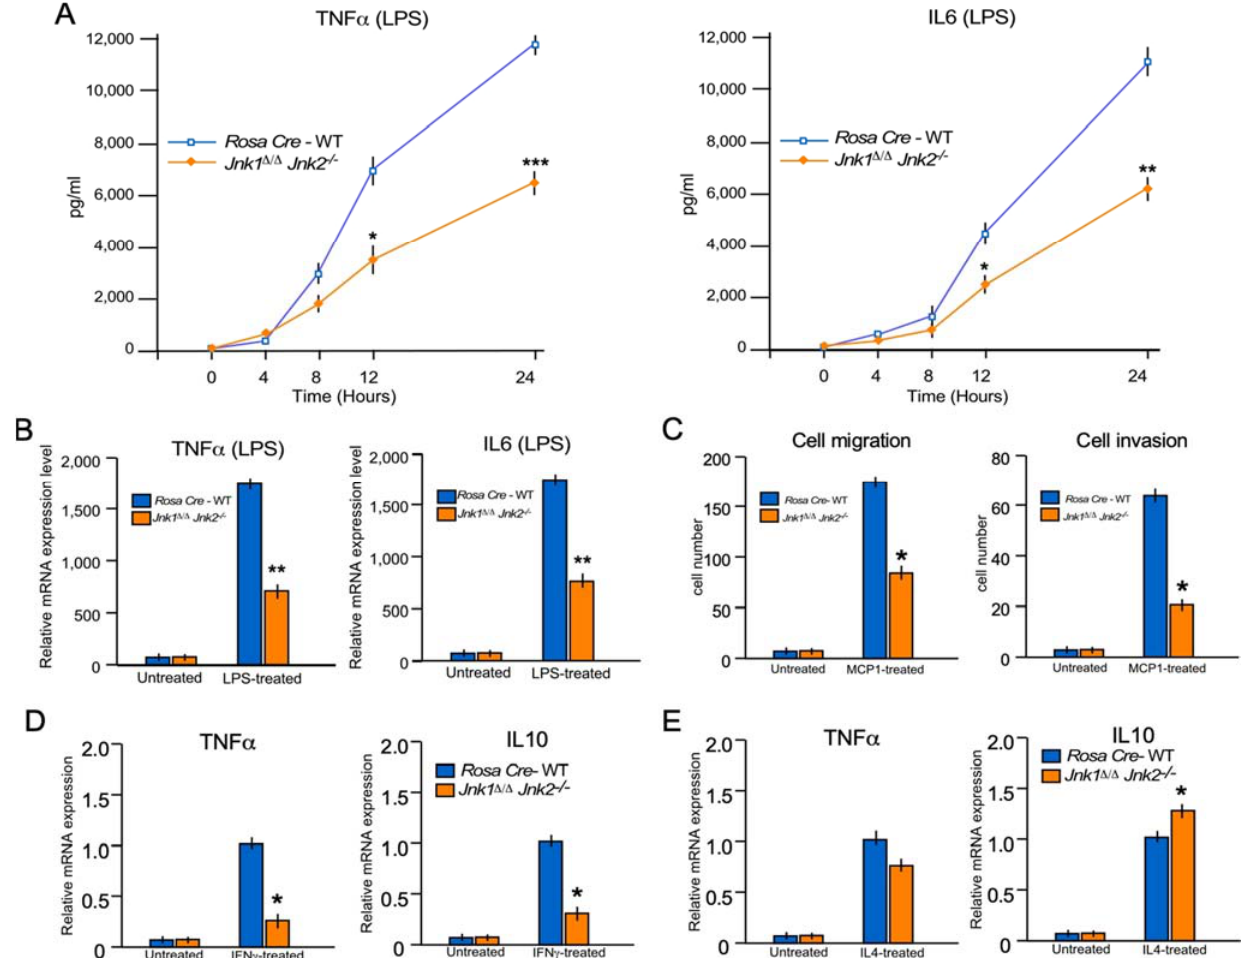
Figure 7. The JNK1/2 mimics the MKK7 phenotype and contributes to LPS-stimulated and cytokine production in macrophages. ( A , B ) Rosa26-Cre ERT and Jnk1 ∆ / ∆ Jnk2 − / − BMDMs were treated with 100 ng/mL LPS. The amount of TNF α and IL6 in the culture medium was measured by ELISA ( A ), and RT-qPCR was performed to measure mRNA production of TNF α and IL6 ( B ). ( C ) Rosa26-Cre ERT , Jnk1 ∆ / ∆ Jnk2 − / − BMDMs were used to measure the migration and Matrigel invasion assay by the Transwell system. ( D ) Total RNA was isolated from BMDM incubated (8 h) without or with 100 ng/mL IFN γ . The relative mRNA expression of M1 (TNF α ) and M2 (IL10) markers were measured by RT-qPCR assays. ( E ) Total RNA was isolated from BMDM incubated without or with 10 ng/mL IL4 (24 h). The relative mRNA expression of the M1 (TNF α ) and M2 (IL10) markers were measured by RT-qPCR assays. (mean ± S.E.M.; n = 6). Statistically significant differences between groups are indicated. (*) p < 0.05; (**) p < 0.01; (***) p < 0.001 vs. WT. All the experiments were repeated 3–4 times.